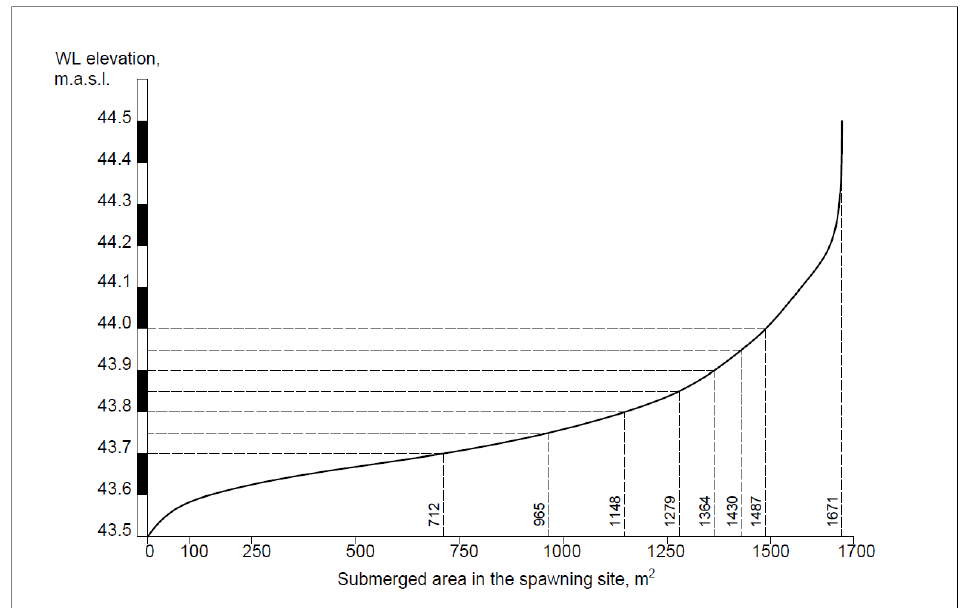
Figure 6. Morphometric curve as a function of the submerged area in the potential spawning site to the water level elevation of the reservoir.